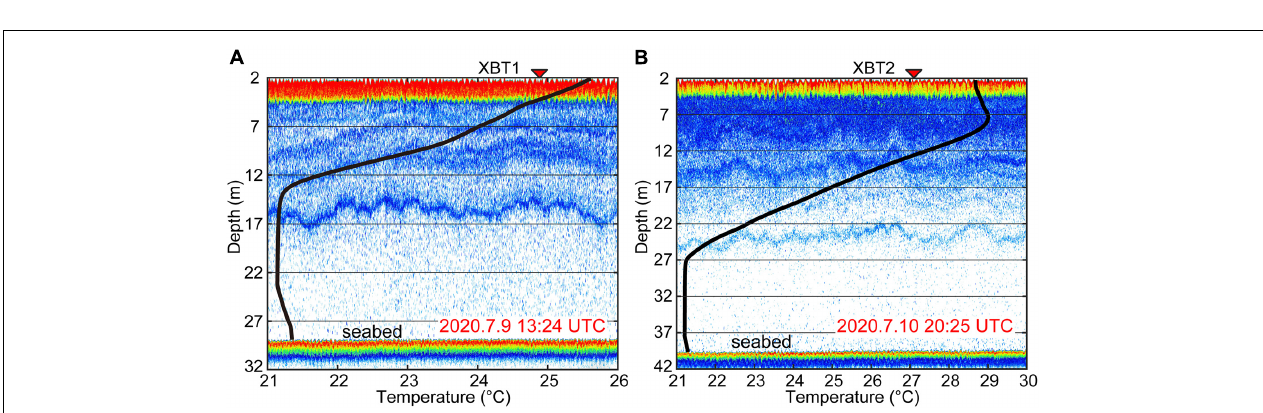
FIGURE 5 | Comparisons of acoustic backscatter images and in situ XBT1 (A) and XBT2 (B) data (black curves) with each other with a small difference of fewer than 3 m, and the red characters indicate the time of acquiring XBT data. Locations of the stations are shown in Figure 1 .